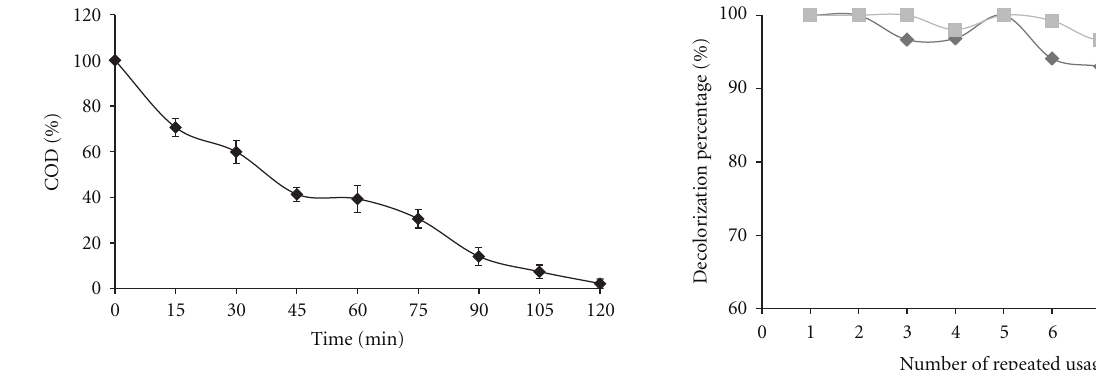
Figure 6: COD reduction in MG solution over time via photo- catalytic degradation using electrospun P(3HB)-50wt% TiO 2 film under solar irradiation.